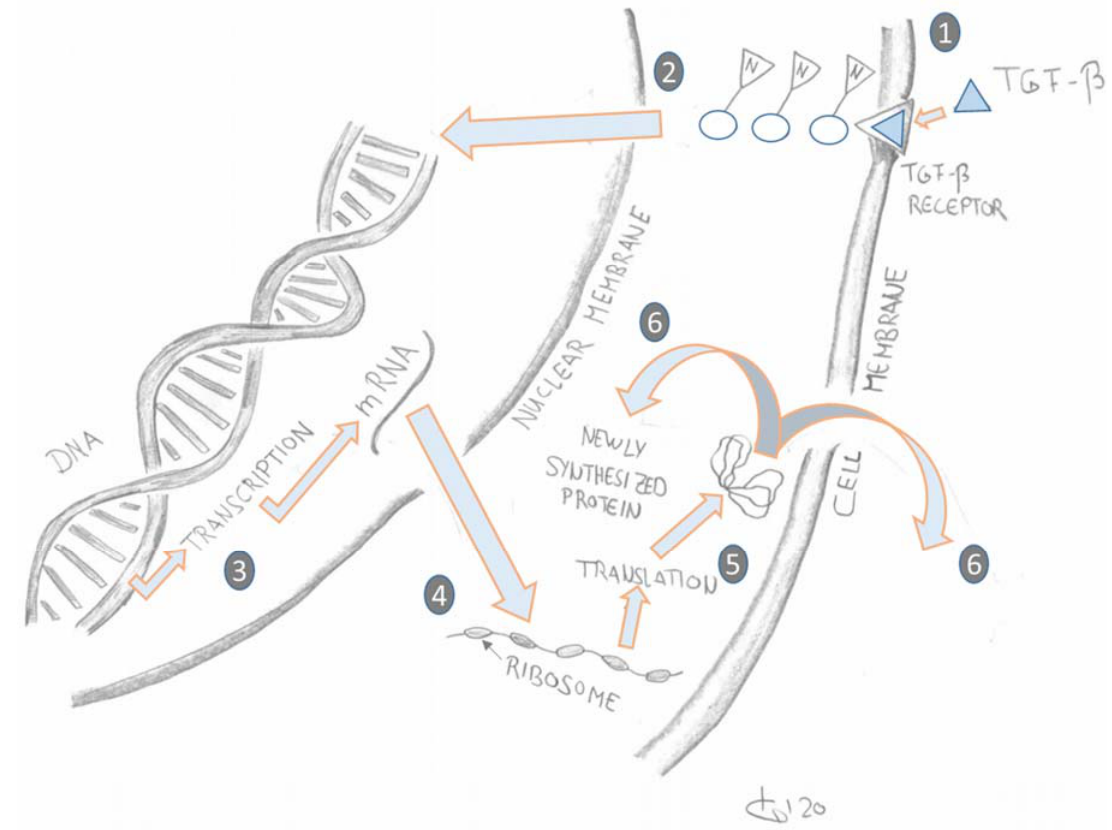
Figure 3. Schematic simplified representation of Transforming Growth Factor Beta (TGF- β ) signal transduction outside and inside the cell [9,10]. (Graphic: T. Koller.) Legend: (1). TGF- β attaches to the TGF- β receptor on the cell membrane. (2&3). Signalling transcription factors transduce the extracellular TGF- β signalling from the cell-bound TGF- β receptors into the nucleus where they activate or inhibit transcription of TGF- β target genes into the respective mRNA sequences. (4&5). In the cytoplasm the mRNA sequences are translated by ribosomes into proteins. (6). The newly synthesized proteins are either exported out of the cell to form collagen or they are used for intracellular processes.